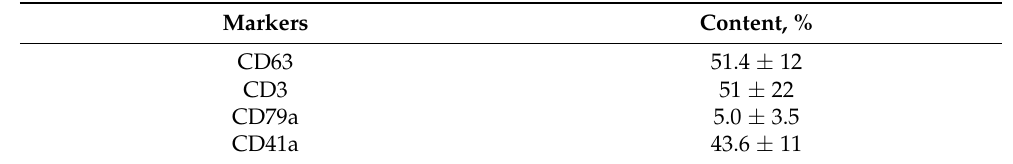
Table 2. FCM analysis of protein markers in blood plasma EVs. The mean values and standard deviations of the contributions of individual fractions to extracellular vesicle preparations obtained from the blood plasma of three different donors are presented.